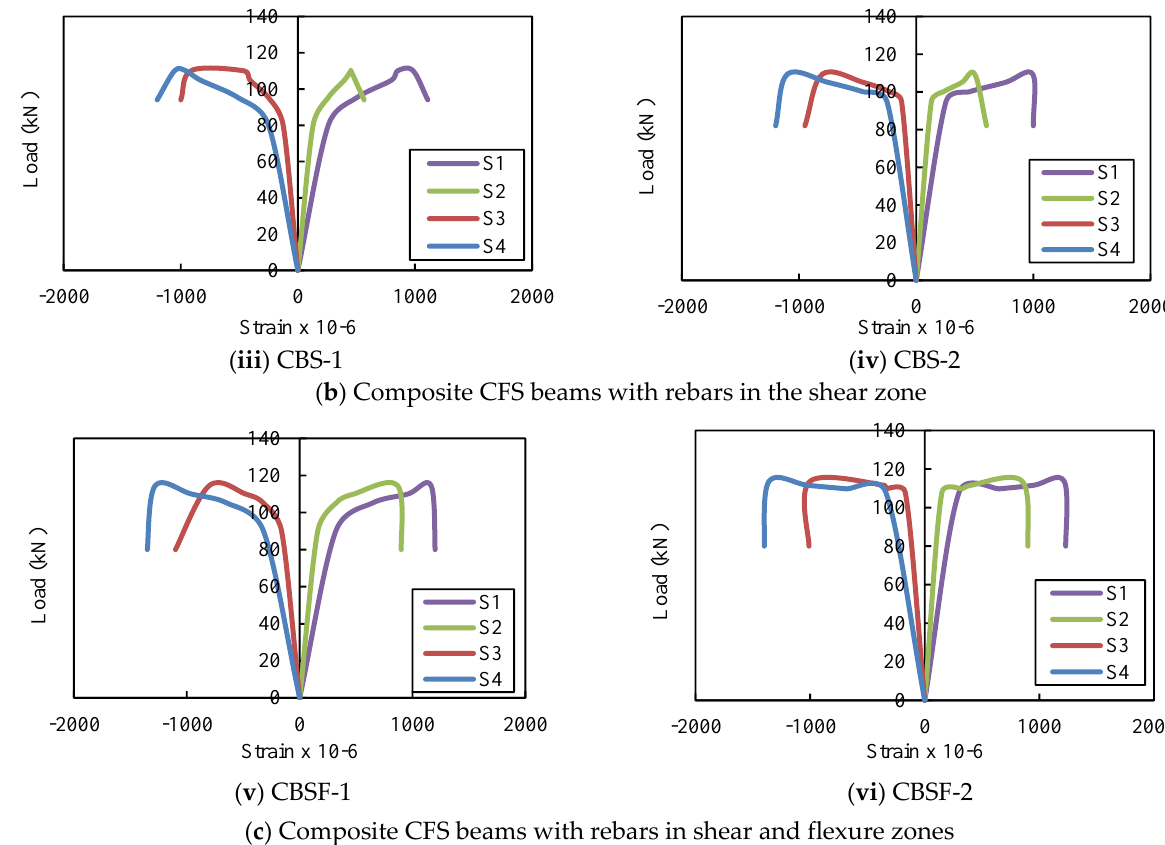
Figure 11. Load versus strain curves of the composite CFS beams.